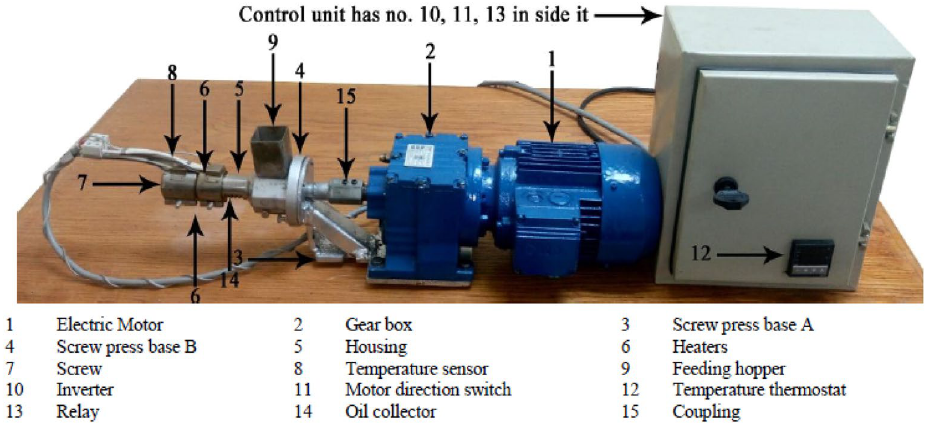
Figure 2. Photograph of the screw press.